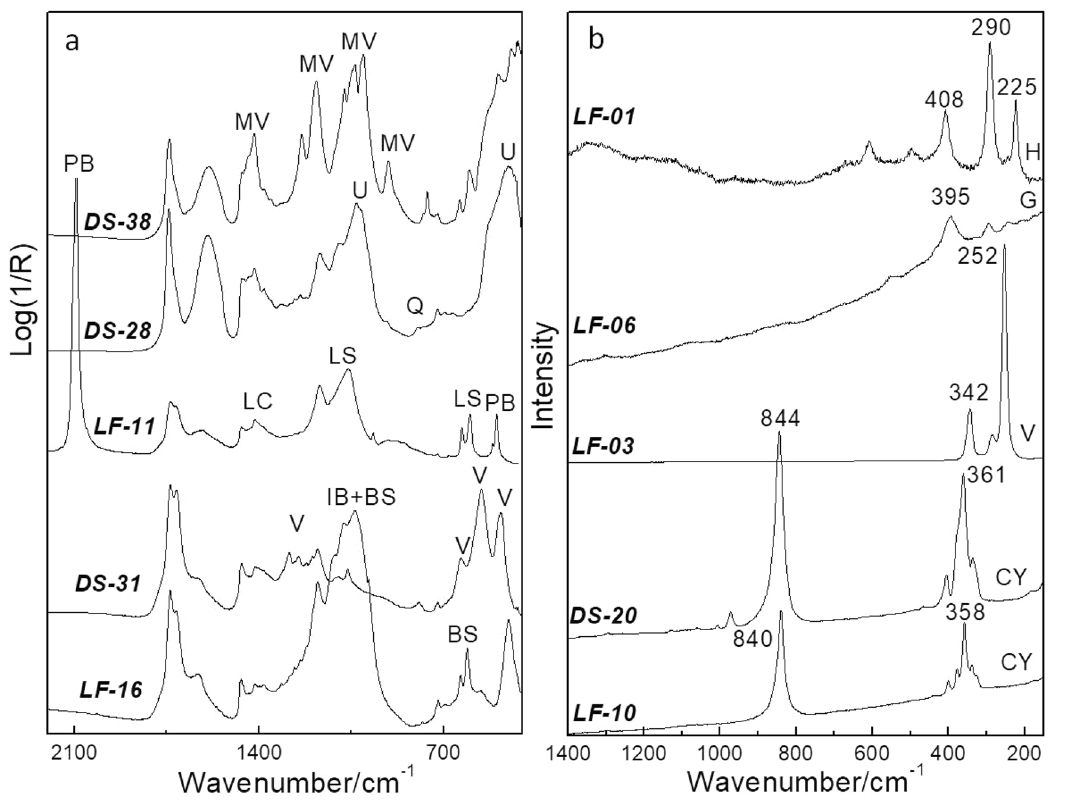
Figure 2. Examples of (a) transmission mode FT-IR spectra, and (b) μ-Raman (λ785 nm) spectra collected from selected LF and DS